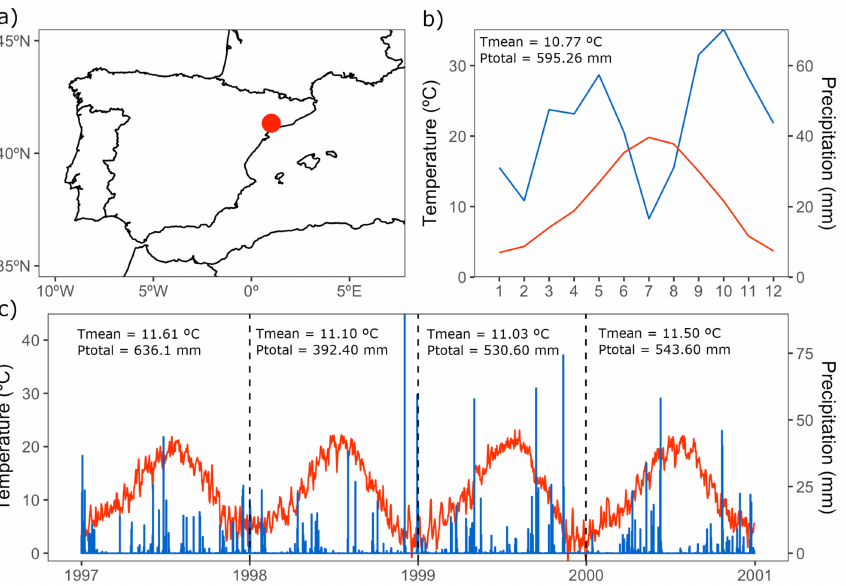
Figure 1. ( a ) Location of the study site (red point). ( b ) Climograph of the study site for the period 1950–2014. Red and blue lines indicate temperature and precipitation, respectively. ( c ) Daily mean temperature (red lines) and total precipitation (blue bars) for the period